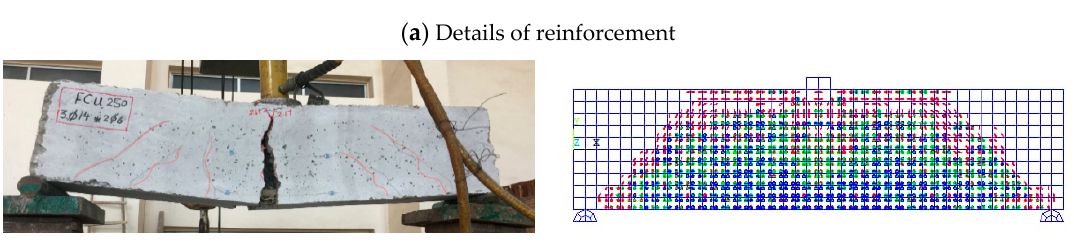
Figure 17. Beam B2 modeling.